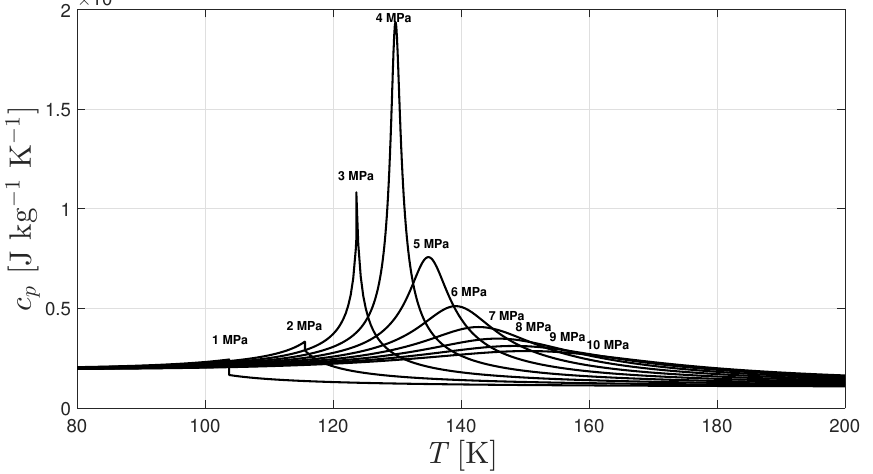
Figure 1. Variation of nitrogen’s isobaric specific heat for a temperature range of 80 to 200 K